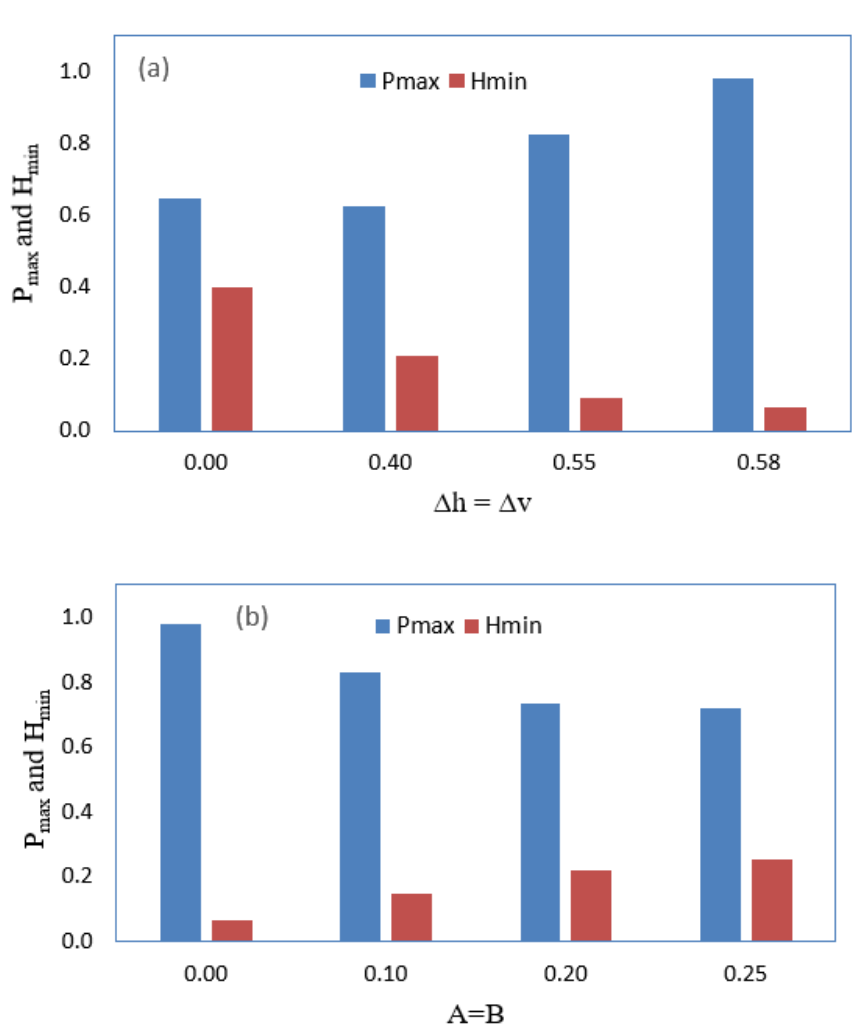
Figure 9. Dimensionless maximum pressure and minimum film thickness for ( a ): unmodified bearing with different misalignment values and ( b ) modified misaligned bearing when ∆ h = ∆ v = 0.58. Table 1. Effect of modification parameters on maximum pressure and minimum film thickness of misaligned bearings (Dimensionless).